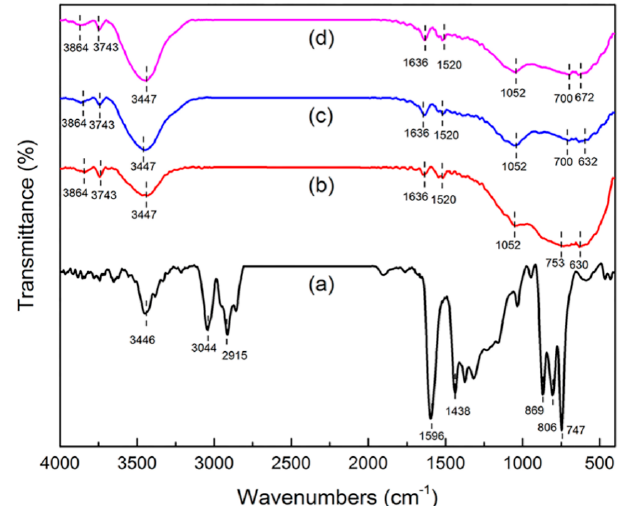
Figure 7. FT-IR spectra of (a) green petroleum coke, (b) N-GLPs 750 2 , (c) N-GLPs 750 4 , and (d) N-GLPs